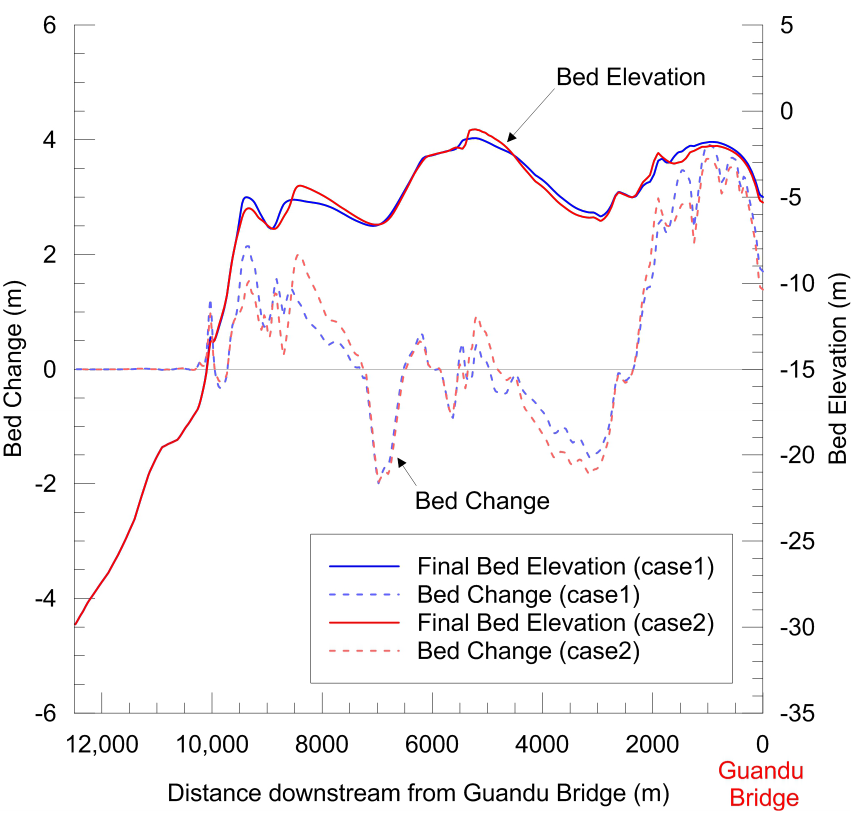
Figure 9. Longitudinal profiles of accumulative bed changes and bed elevations along the transect through the middle of the river from the Guandu Bridge to 2500 m of the outer sea of the estuary (dotted line A–A’ in Figure 6b).